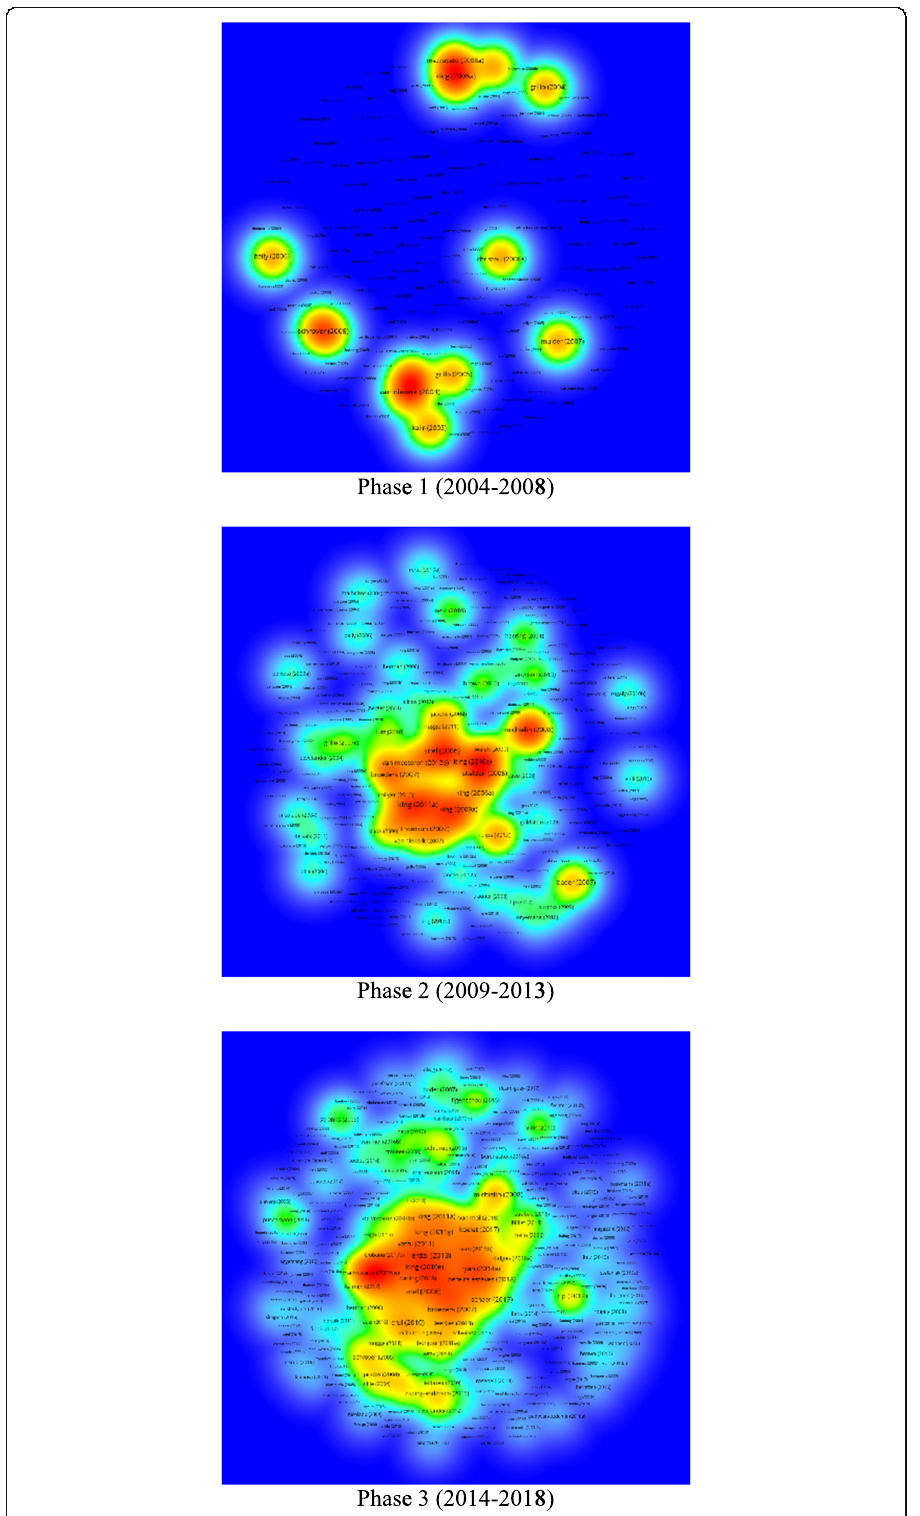
Fig. 3 Density of citation links between IMISCOE articles over 3